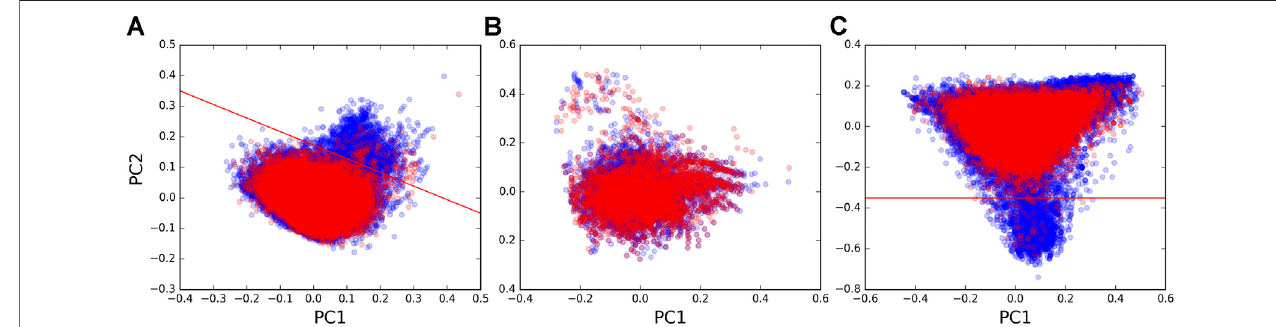
FIGURE 2 | PCA plots of dinucleotide composition. Plots of the fi rst vs. second principal components calculated from dinucleotide frequencies (counting all overlapping dinucleotides) are shown for (A) tRF – mRNA chimeric sequences, (B) tRF sequences, and (C) mRNA target sequences that were identi fi ed in forward pairs (blue points) and reverse pairs (red points). Red lines separate the region enriched with polyT runs from the rest of the